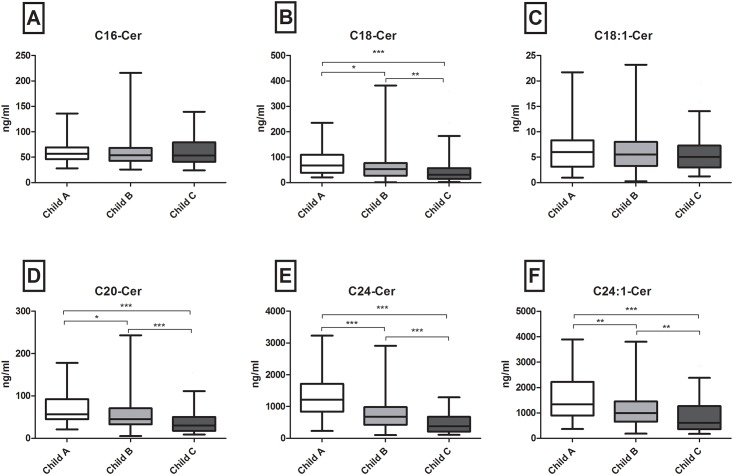
Severity of cirrhosis associates with a decrease of serum Cer levels.C18, C20, C24 and C24:1Cer are significantly decreased with progression of cirrhosis, defined by the Child-Pugh score (p<0.001 in Child A versus Child C cirrhosis respectively). No differences in levels of C16 and C18:1Cer are identified, whereas the most significant decrease is observed in serum C24Cer levels (p<0.001 for all comparisons, 2E). Pairwise comparisons were used as post hoc analysis for significant overall differences. Cer: ceramide.